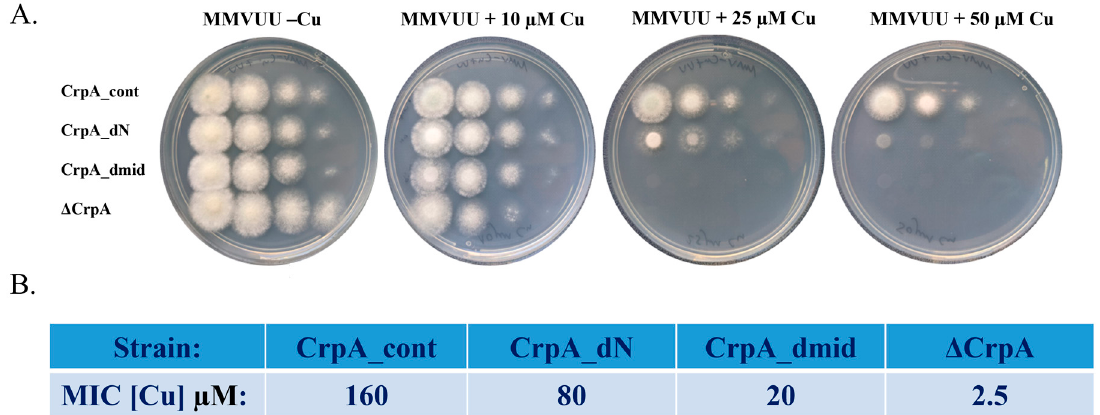
Figure 2. The A. fumigatus CrpA intracellular loop (amino acids 542–556) is essential for growth at high concentrations of Cu. A. fumigatus strains CrpA_cont, CrpA_dN (CrpA N-terminal amino acids 1–211 deleted), CrpA_dmid (CrpA intracellular loop amino acids 542–556 replaced), and ∆ CrpA strains were grown on MMVUU. ( A ) Agar plates supplemented with increasing concentrations of Cu. Conidial droplets containing increasing numbers of conidia (10, 100, 1000, and 10,000 from right to left) were placed on the plates and incubated for 72 h at 37 ◦ C. ( B ) Liquid broth Cu-sensitivity assay with increasing concentrations of Cu for 48 h at 37 ◦ C for MIC